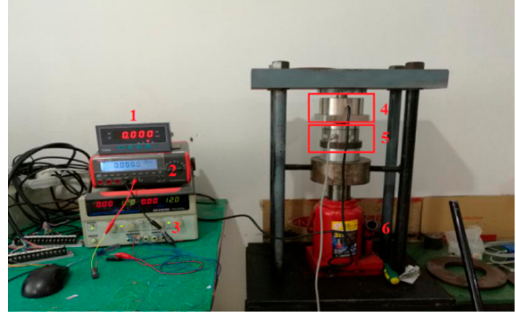
Figure 15. Experimental setup. ( 1 ) Displayer 1; ( 2 ) Displayer 2; ( 3 ) DC power; ( 4 ) Acoustic filtering sensor; ( 5 ) Standard sensor; ( 6 ) Hydro-cylinder. sensor; ( 5 ) Standard sensor; ( 6 )